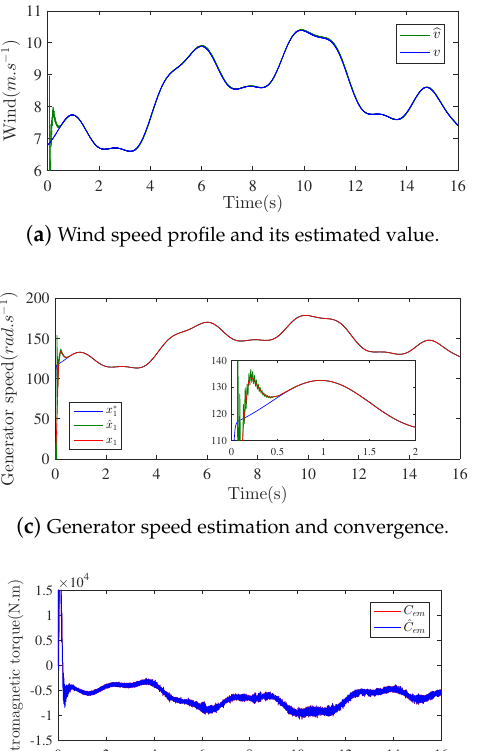
( h ) Mechanical torque estimation error.